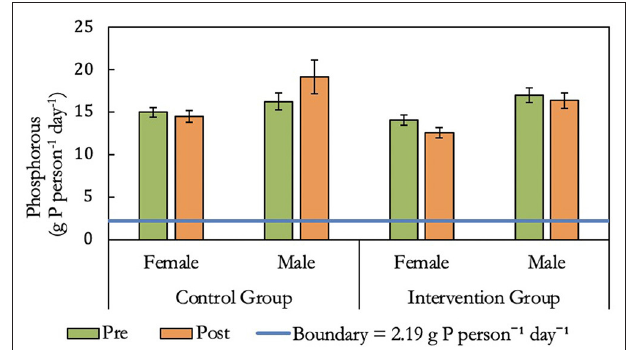
FIGURE 5 | Changes in dietary phosphorus footprint from baseline to follow up for female and male students in the intervention and control group. The per capita food-related planetary boundary of 2.19g P person − 1 day − 1 (for a population of 10 billion in 2050) is shown by the blue line.